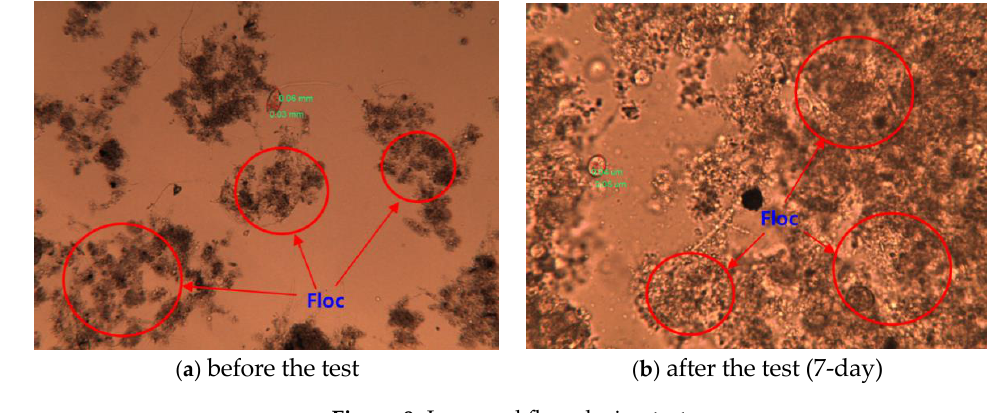
Figure 9. Increased flocs during test.